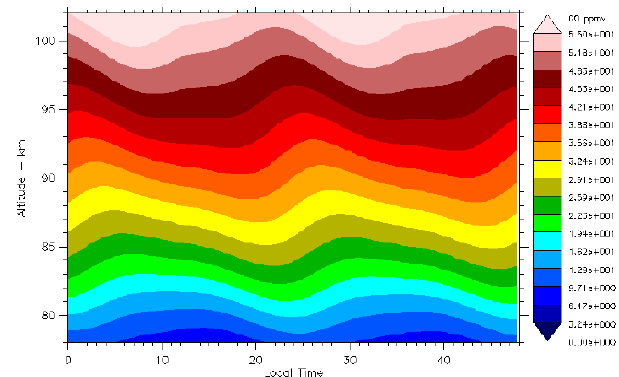
Fig. 5b. Model diurnal tide for CO for April, days seven through eight, for comparison with the ACE-FTS sunrise/sunset observa- tions. At 90km altitude the sunrise mixing ratio is smaller than the sunset mixing ratio, as in Fig.